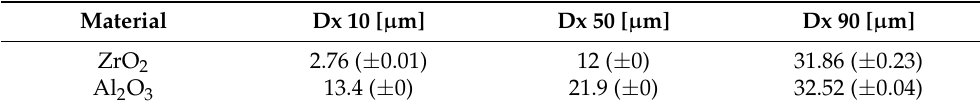
Table 5. Particle size distribution of the modified ZrO 2 and Al 2 O 3 powders.